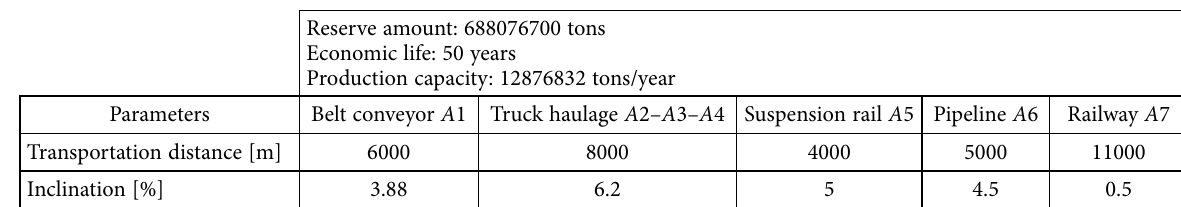
Table 2. Site operation data